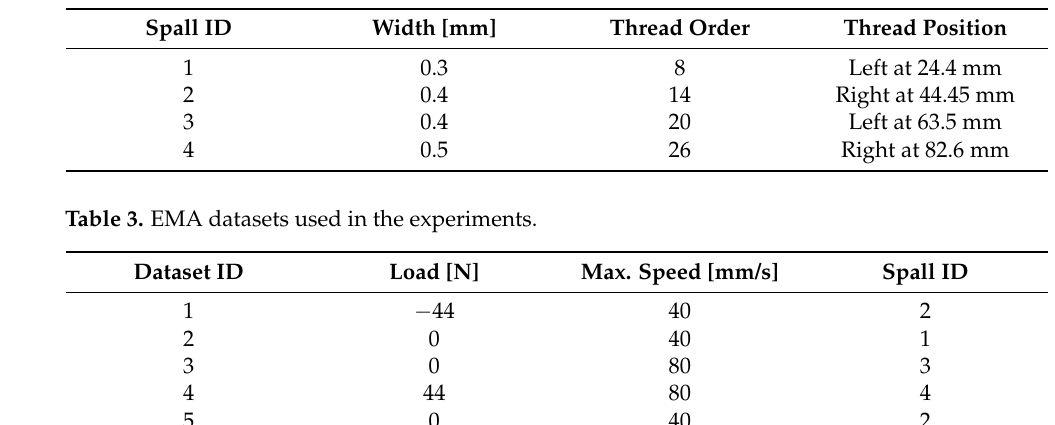
Table 2. Spall injection locations.